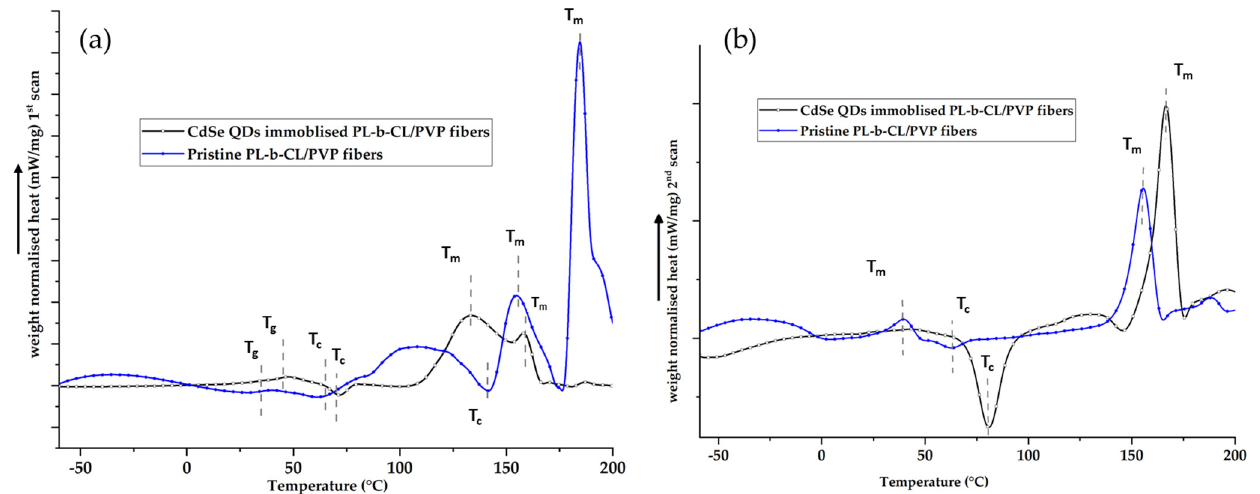
Figure 7. DSC curve of pristine and CdSe QDs-immobilized PL-b-CL/PVP nano fi bers exhibiting di ff erence in their phase (T g , T m ) change behavior due to presence of QDs and interaction with PL- b-CL copolymer (1 st scan ( a ) and 2nd scan ( b )). T g —glass transition temperature; T c ‒